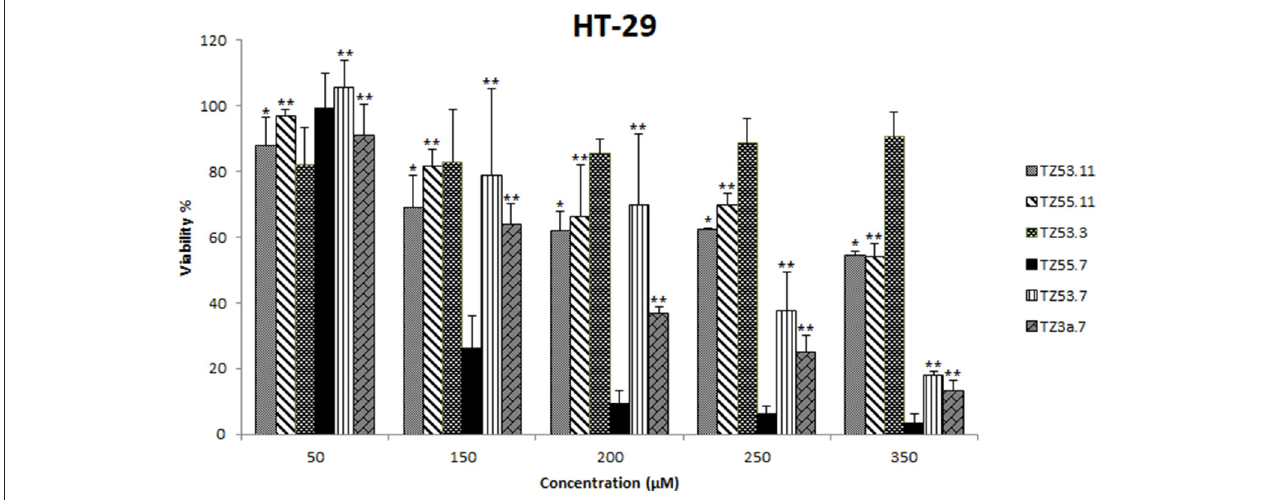
FIGURE 6 | Cell viability recorded on HT-29 cell line, for the tested compounds TZ53.3, TZ53.7, TZ55.7, TZ3a.7, TZ53.11, TZ55.11, at concentrations of: 50, 150, 200, 250, and 350 µ M; (* p < 0.05; ** p <